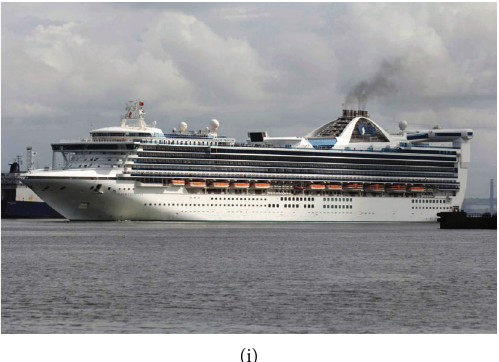
Figure 7: Comparison experiment of di ff erent methods on synthetic hazy images in surface ship images. From top-left to bottom-right: (a) synthetic hazy image and restored images, generated by (b) DCP [19], (c) nonlocal [37], (d) F-LDCP [20], (e) AODNet [25], (f) GCANet [26], (g) MSCNN [24], (h) ours, and (i) ground truth,